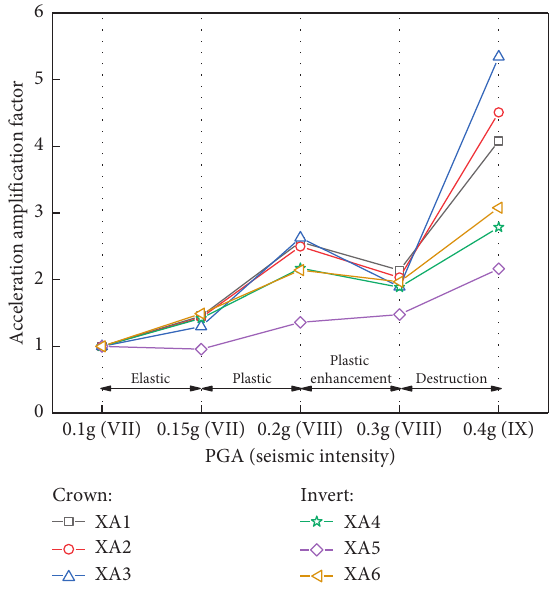
Figure 12: Acceleration amplification factor of the under-crossing